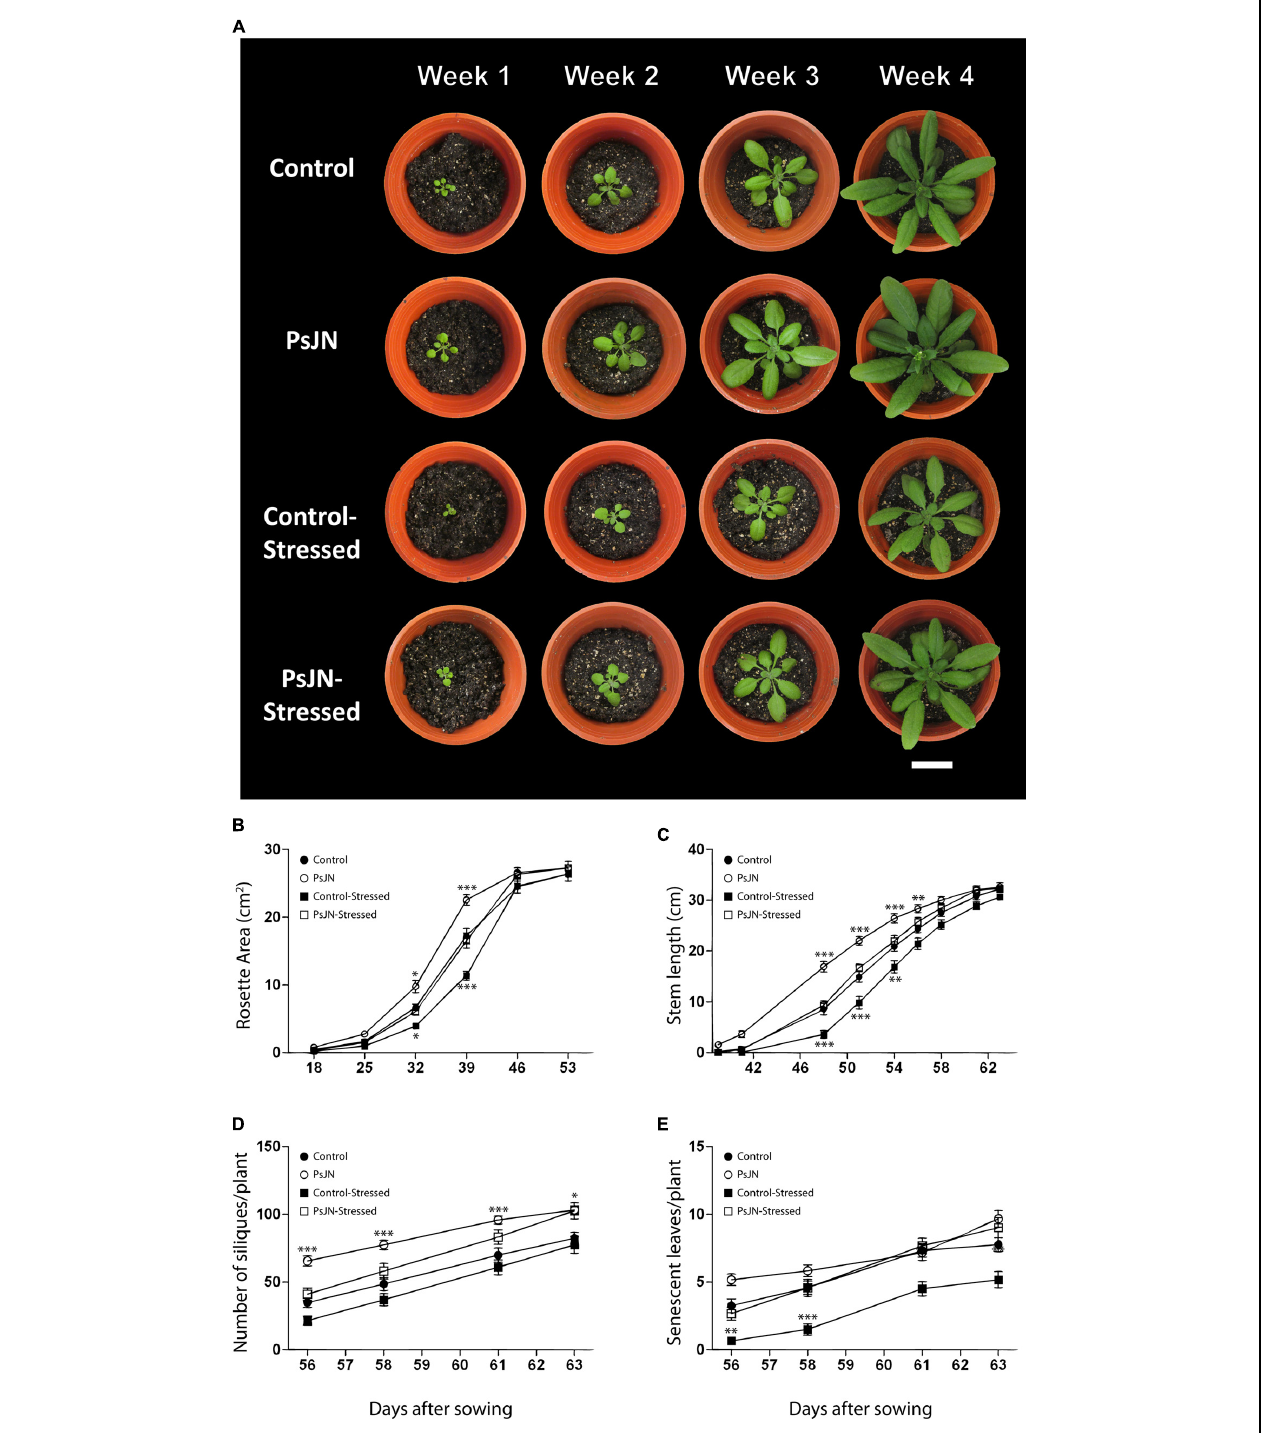
(B) , average stem length (C) , average number of siliques/plant (D) , and average number of senescent leaves/plant (E) of plants under the experimental conditions described before. Data are means ± 1 SE of at least 12 plants per treatment. Asterisks indicate significant differences between control treatment and the other treatments in each time (Two-way ANOVA, p < 0.05; Bonferroni test, ∗ P < 0.1; ∗∗ P < 0.05; ∗∗∗ P < 0.01). White bar in photograph corresponds to 2